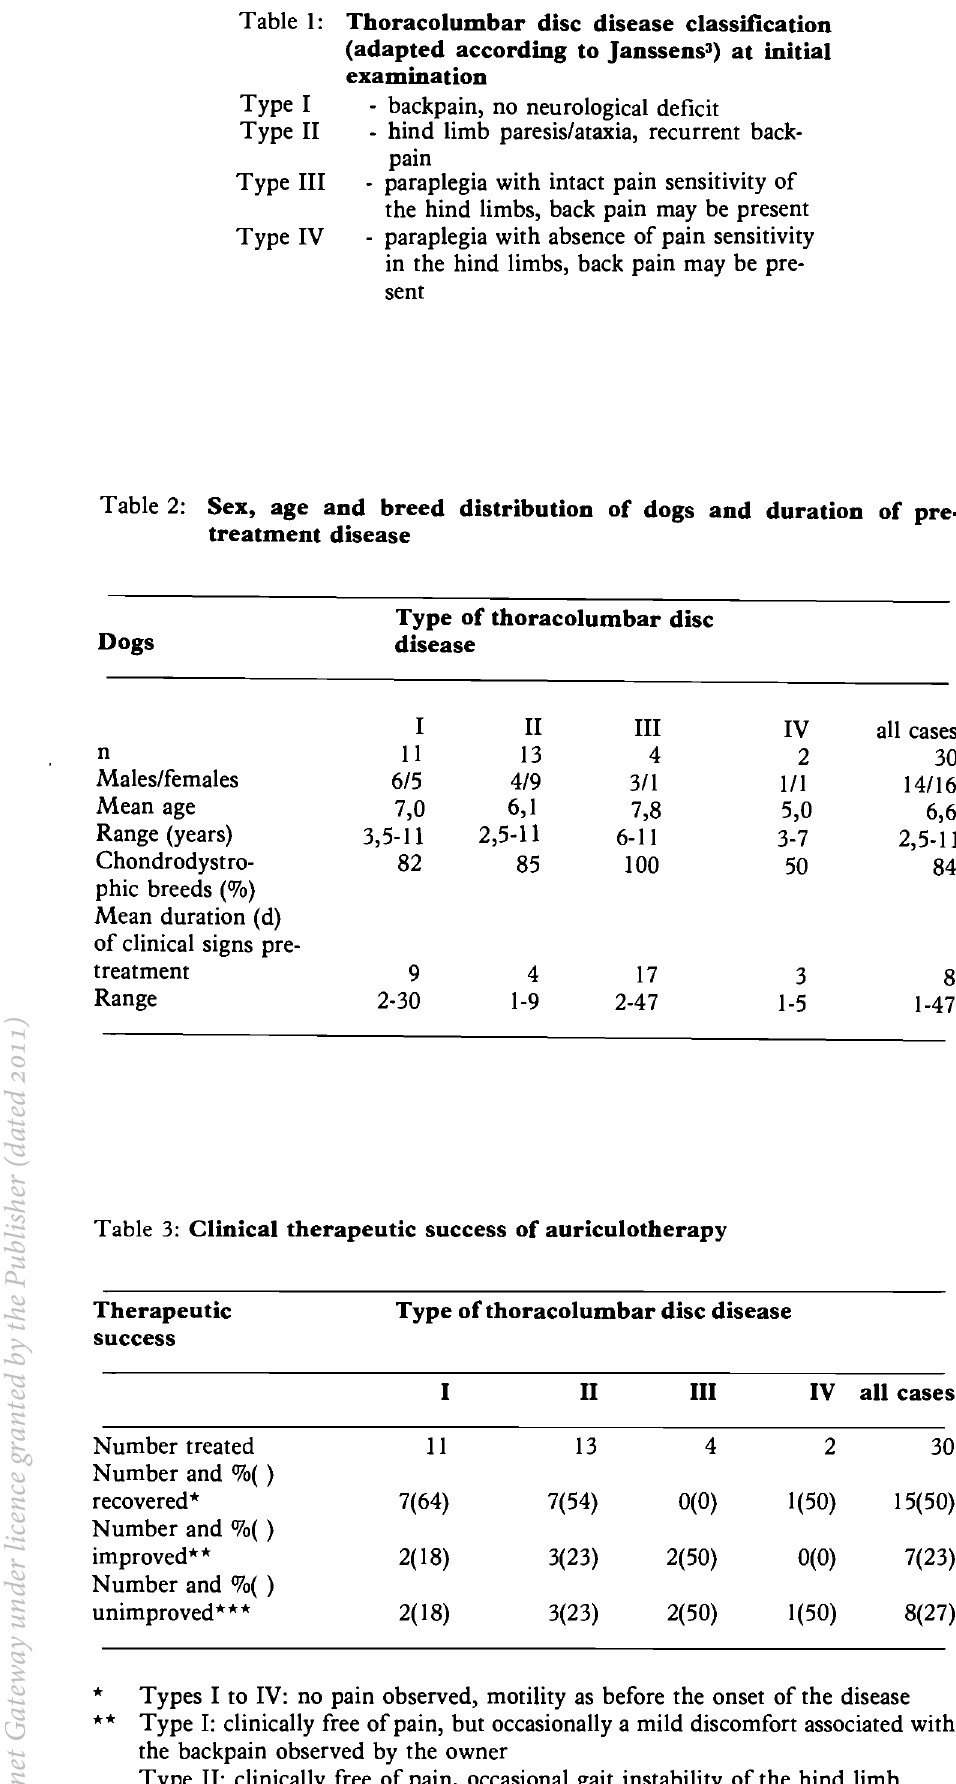
Table 2: Sex, age and breed distribution of dogs and duration of pre treatment disease